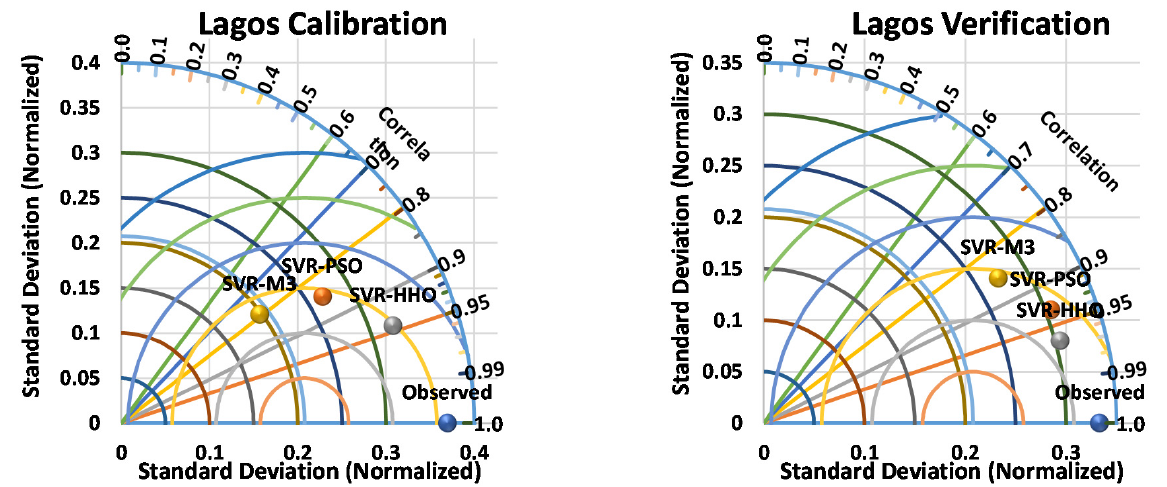
Figure 11. Taylor diagram for the best models in both calibration and verification. The simulated results can be better visualized using a time series graph, as presented in Figure 12. From these figures, the optimal predicted load is attributed to the SVR-HHO algorithm in all four states, despite the simultaneous reliability of SVR-PSO.